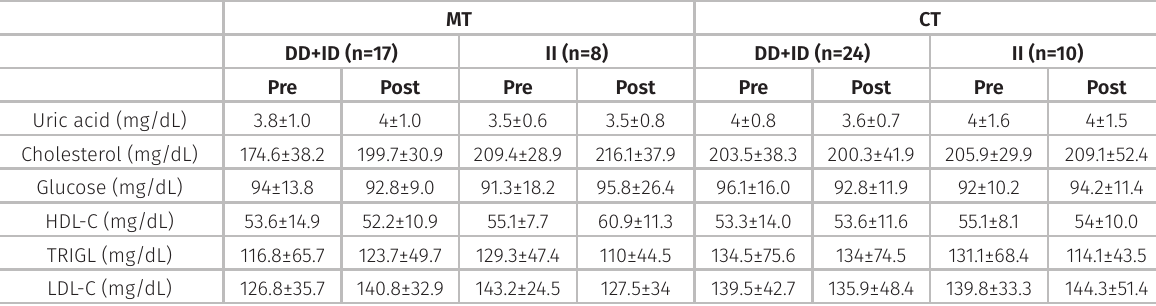
Table IV. Blood analyses of MT and CT groups related to ACE